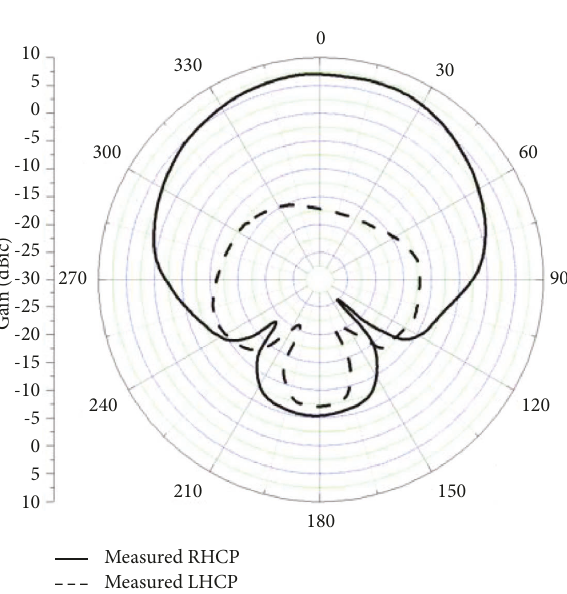
Figure 7: S 11 at various patch sizes.